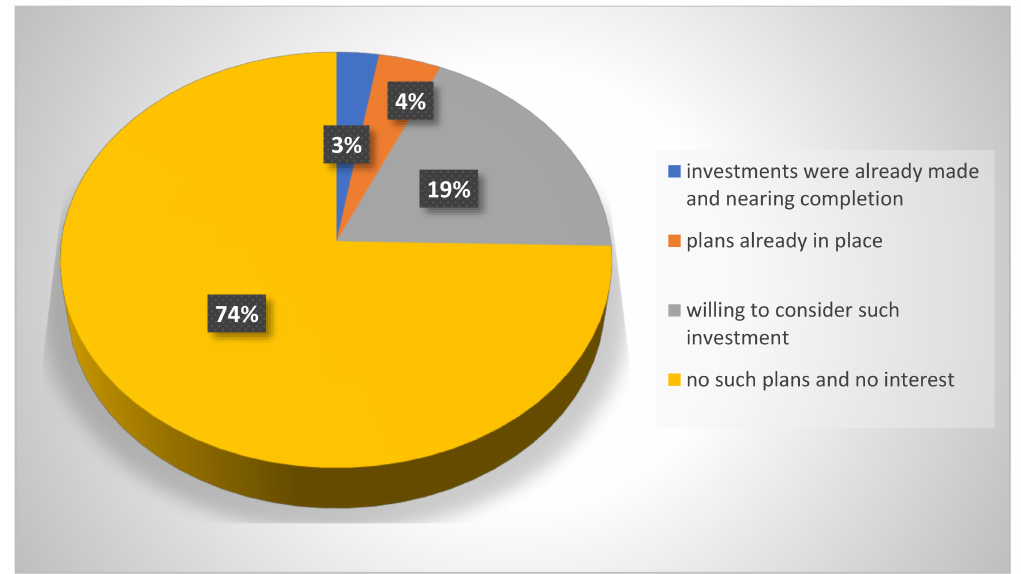
Figure 6. Households’ investments, interest and plans to install RES.